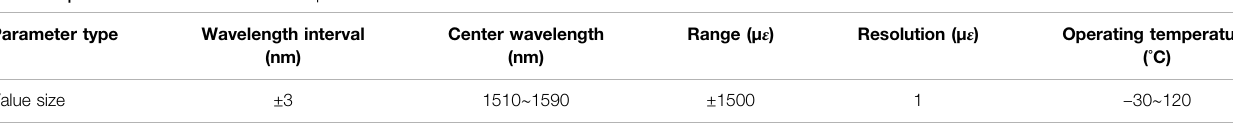
TABLE 3 | sensitization micro FBG sensor parameter table.